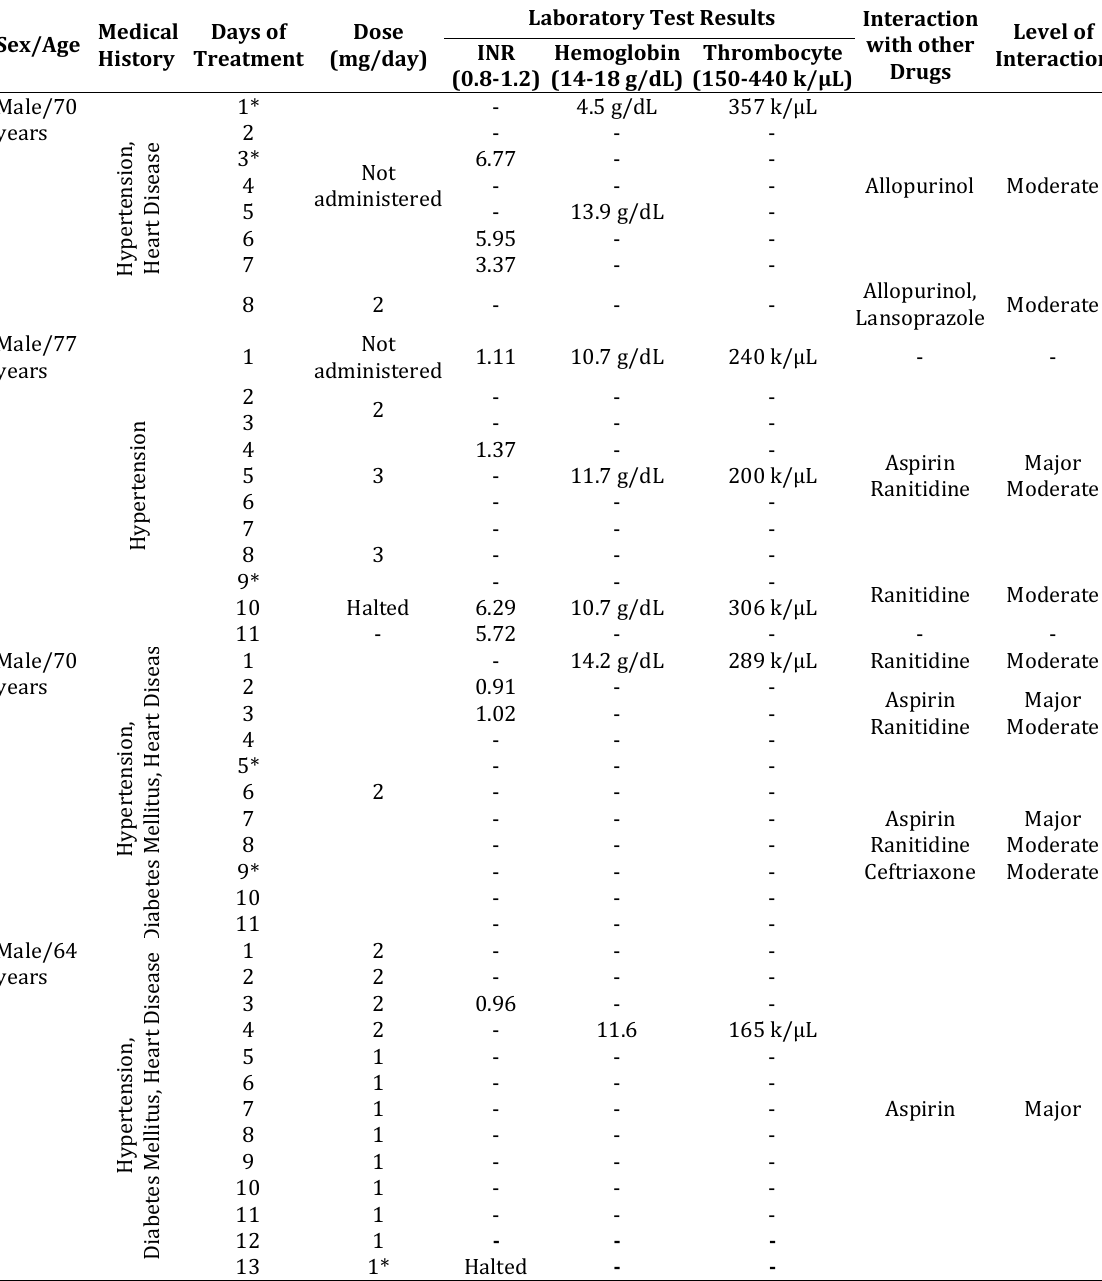
Table III. Incidence of bleeding associated with warfarin use Medical Sex/Age